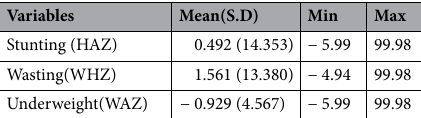
Table 1. Descriptive statistics of response